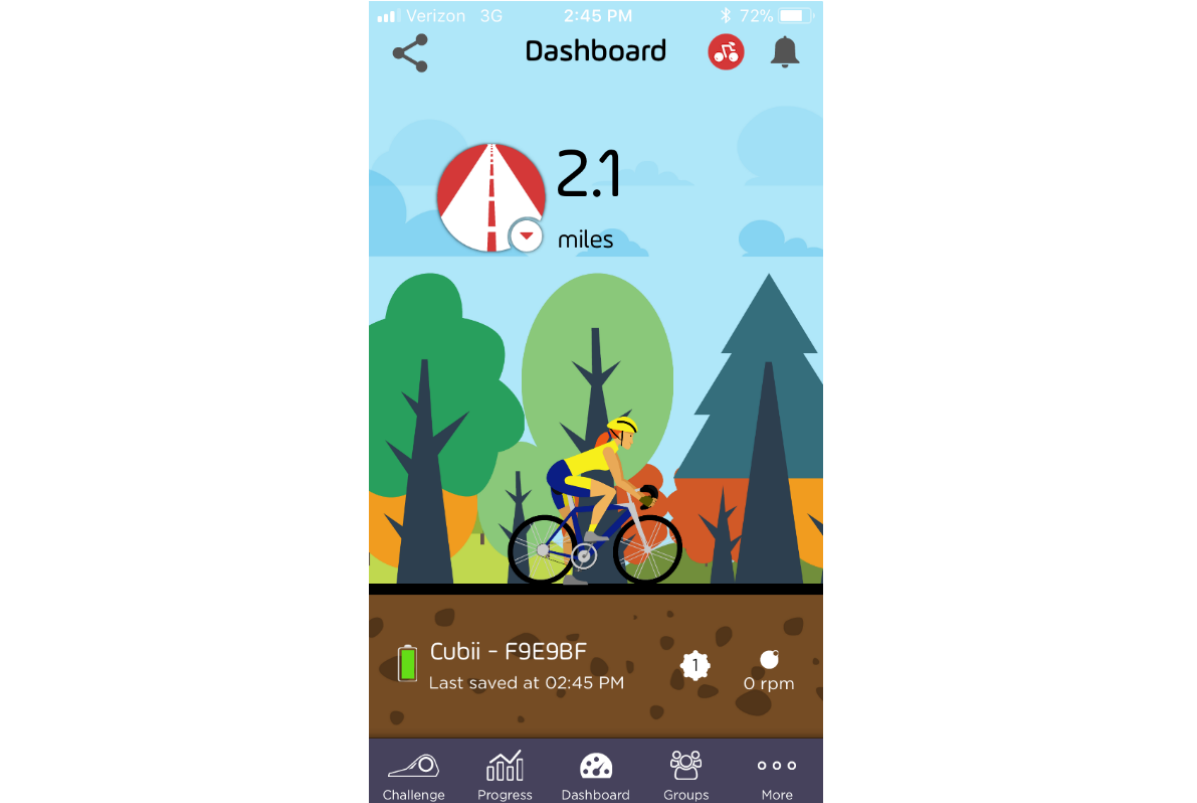
Figure 2. Screenshot of Cubii mobile app dashboard with real-time pedaling